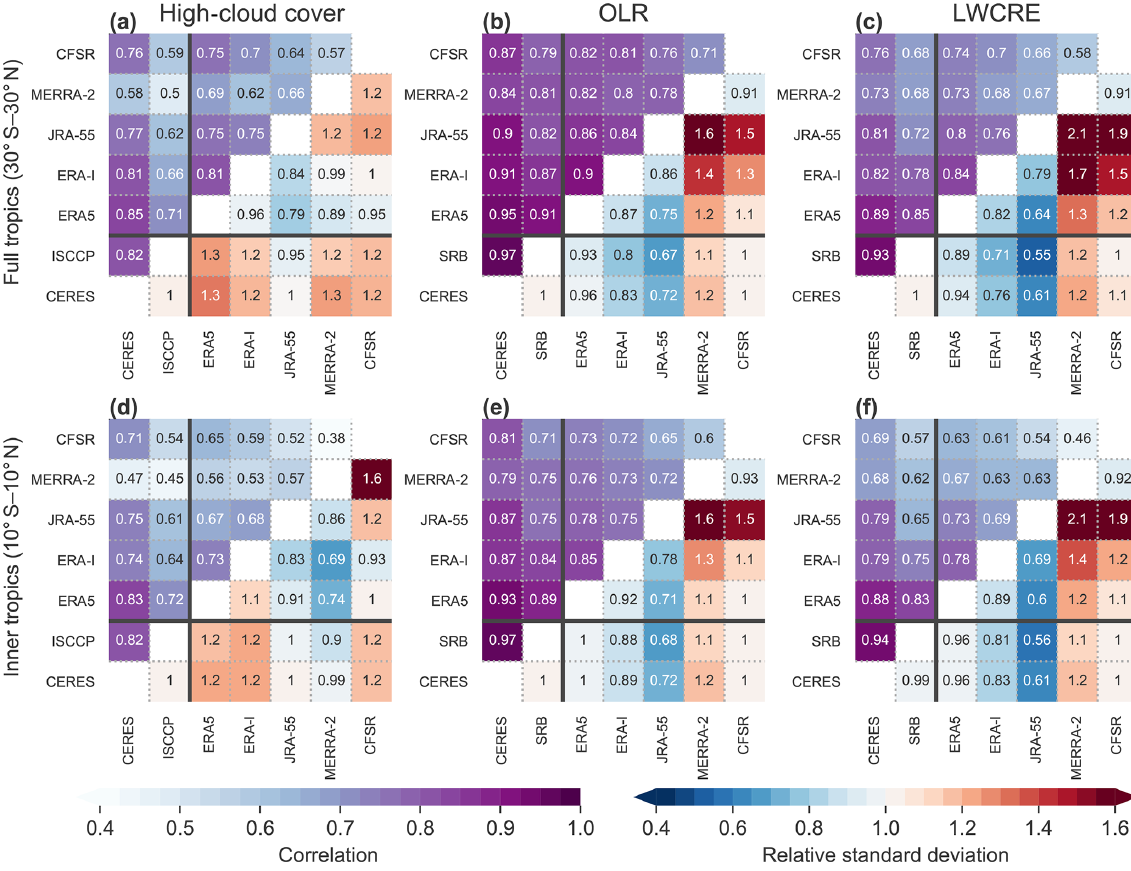
Figure 15. Metrics measuring agreement in monthly anomalies of (a, d) HCC, (b, e) OLR, and (c, f) LWCRE among the reanalyses and observational data sets examined in this paper (in which ERA-Interim is abbreviated ERA-I). The upper-left triangle in each panel shows correlation coefficients between each pair of products, while the lower-right triangle shows the standard deviation in the product marked on the horizontal axis relative to that in the product marked on the vertical axis. Both metrics are evaluated first for individual grid cells in the 2.5 ◦ common grid (see e.g. Fig. 1) and then averaged. The upper row (a–c) shows results for the entire tropics (30 ◦ S–30 ◦ N), while the lower row (d–f) shows results for the inner tropics only (10 ◦ S–10 ◦ N). Solid black lines separate evaluations relative to the observational benchmarks based on CERES, ISCCP, and NASA/GEWEX SRB from those based on intercomparison of reanalysis